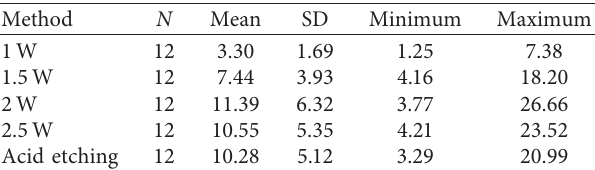
Table 3: Descriptive statistics of different laser and acid etching groups (MPa).